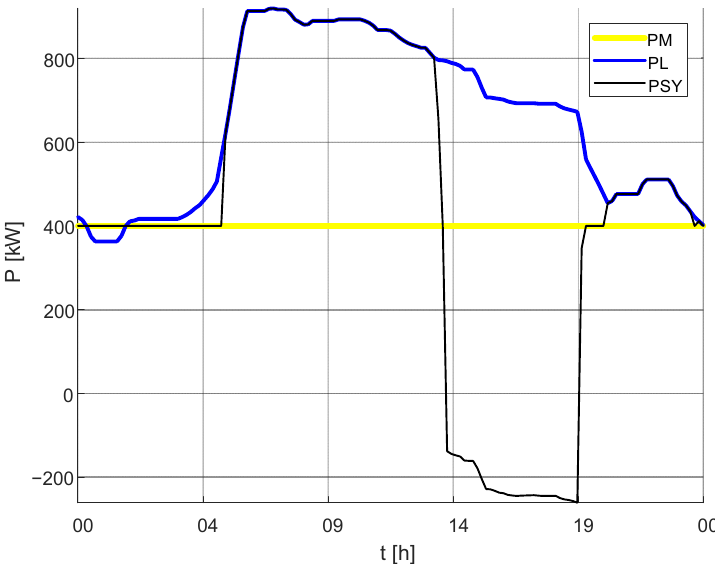
Figure 15. Results of the simulation of the operation of the private network with the BESS with real characteristics for the set exchange power PM 400 kW; PSY—exchange power with the distribution grid and PL—load.